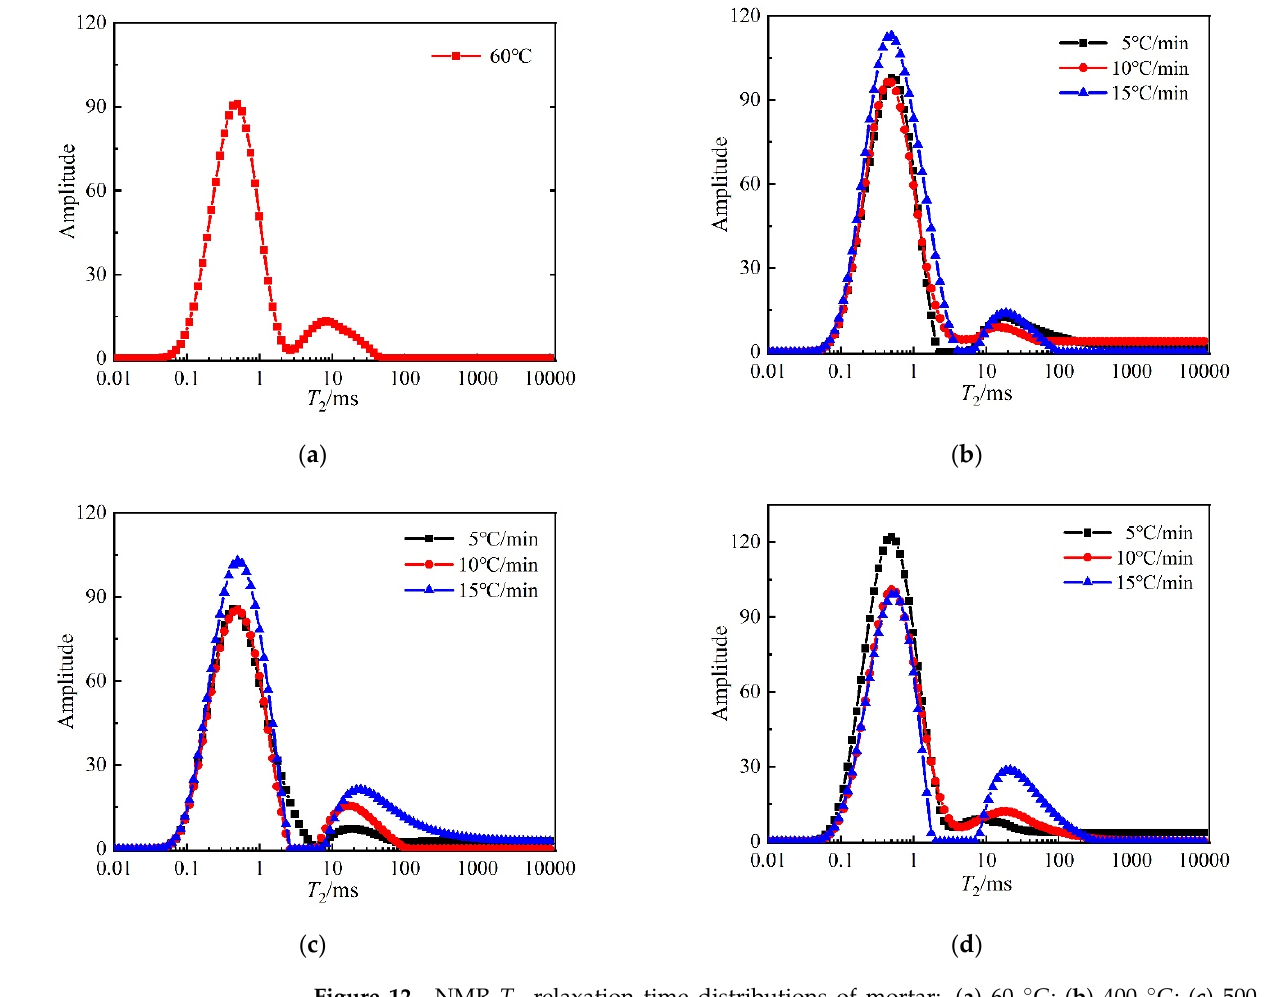
◦ C; ( b ) 400 ◦ C; ( c ) 500 ◦ C;